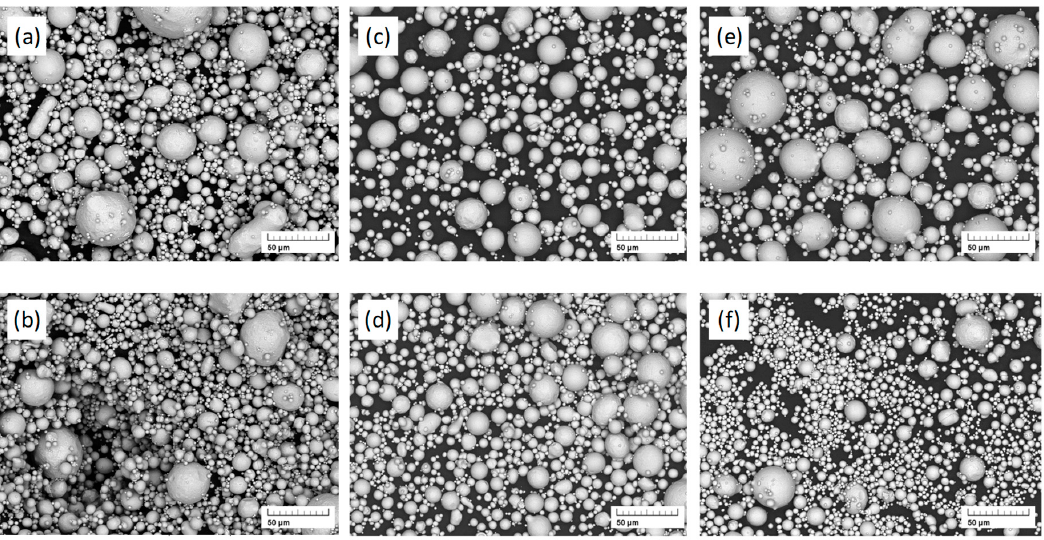
Figure 3. Particle size distributions of the gas atomized 316L and modified 316L powders. The nomenclature used in the diagram, for instance Ar/N2, indicates that the first element corresponds to the melting atmosphere and the second to the atomization gas.